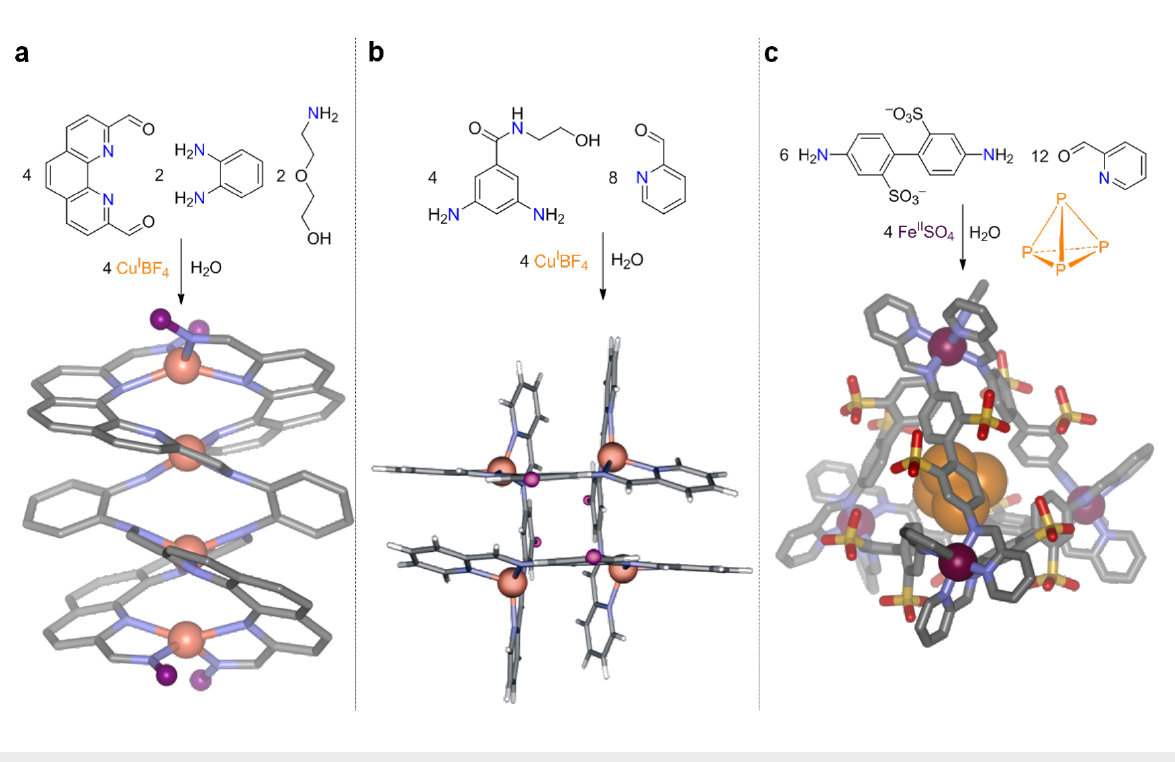
Figure 1: Complex structures prepared from simple subcomponents: a) Cu I 4 helicate [7]; b) Cu I 4 grid [8]; c) Fe II 4 tetrahedral cage